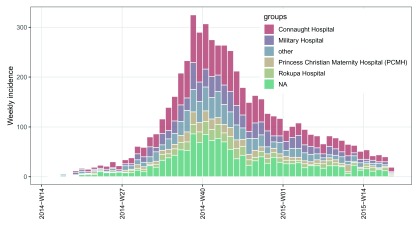
Weekly epicurves stratified by hospitals for the simulated outbreak of EVD.